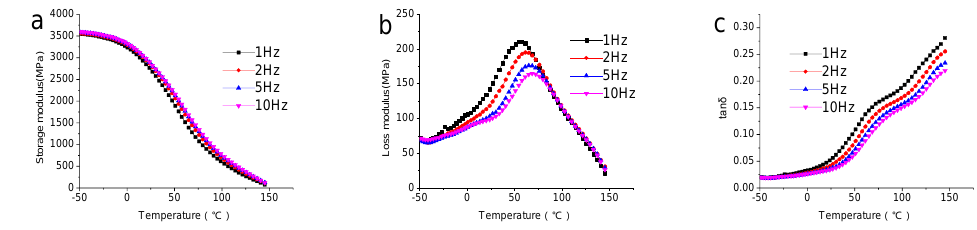
Figure 2. Variation of ( a ) E′; ( b ) E′′ and ( c ) tan δ with frequency of composites (biochar-30 wt %).